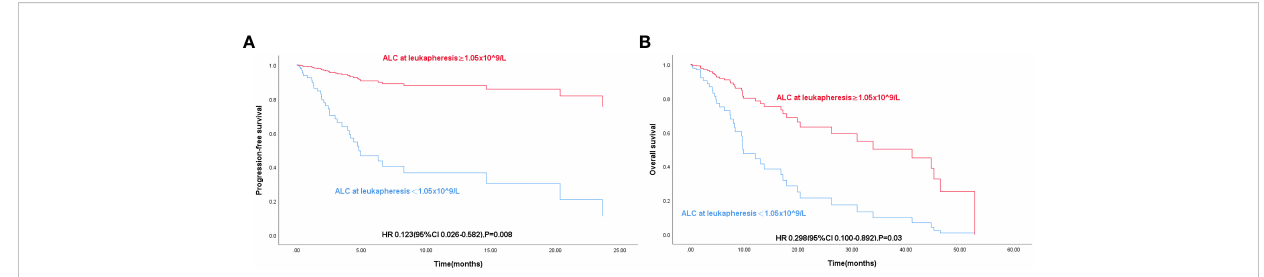
FIGURE 2 (A) K-M curve of progression-free survival in 84 patients with R/R DLBCL according to Pre-LD ALC grouping. (B) K-M curve of overall survival in 84 patients with R/R DLBCL according to Pre-LD ALC